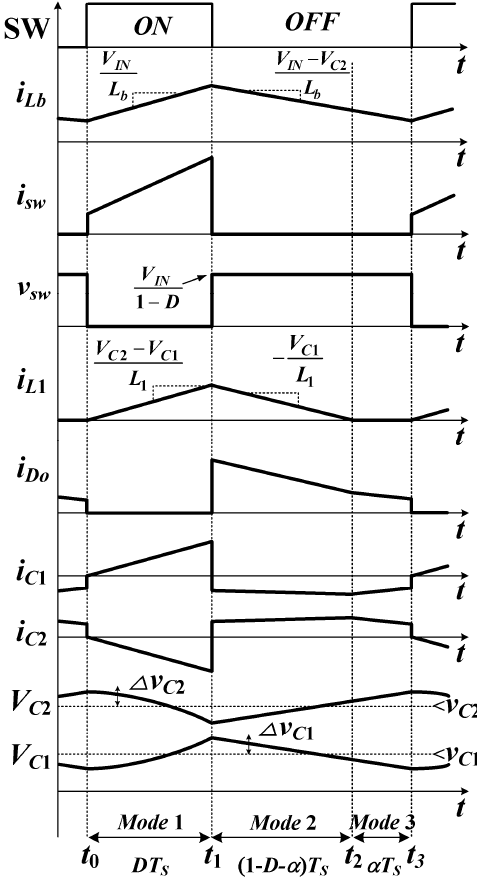
Figure 5. Operating waveforms of the proposed DC–DC boost converter.